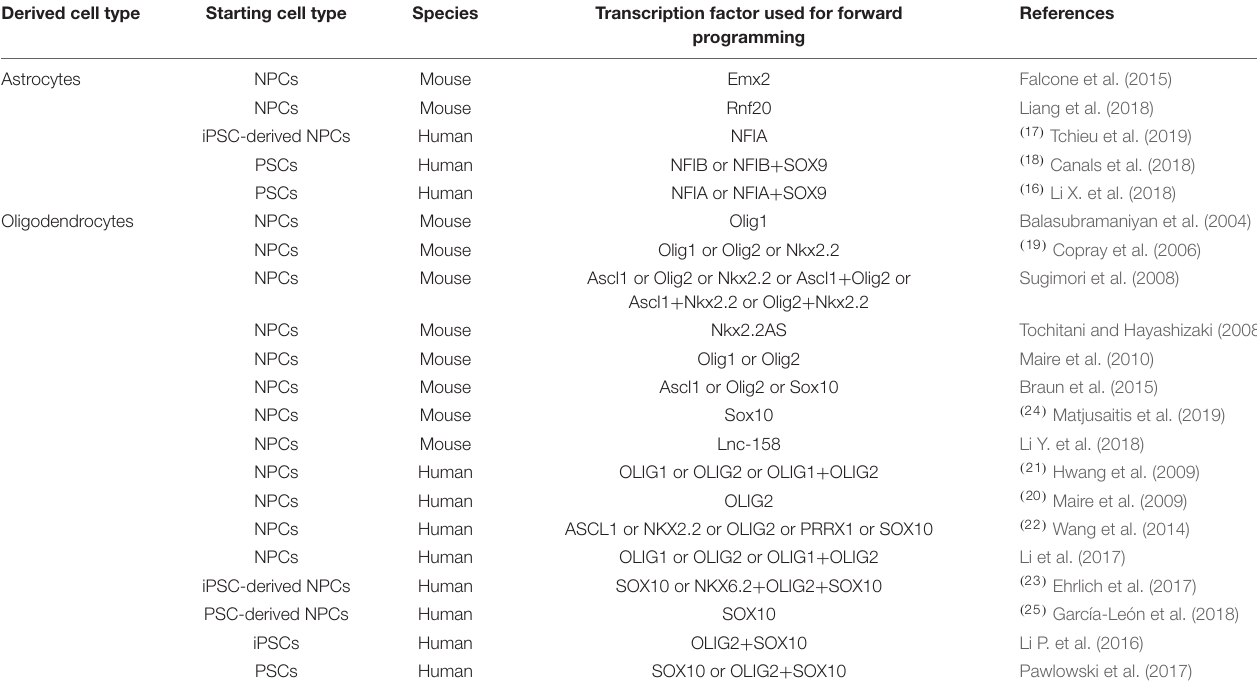
TABLE 2 | Transcription factors used for promoting glial differentiation of neural precursor cells and pluripotent stem cells in vitro